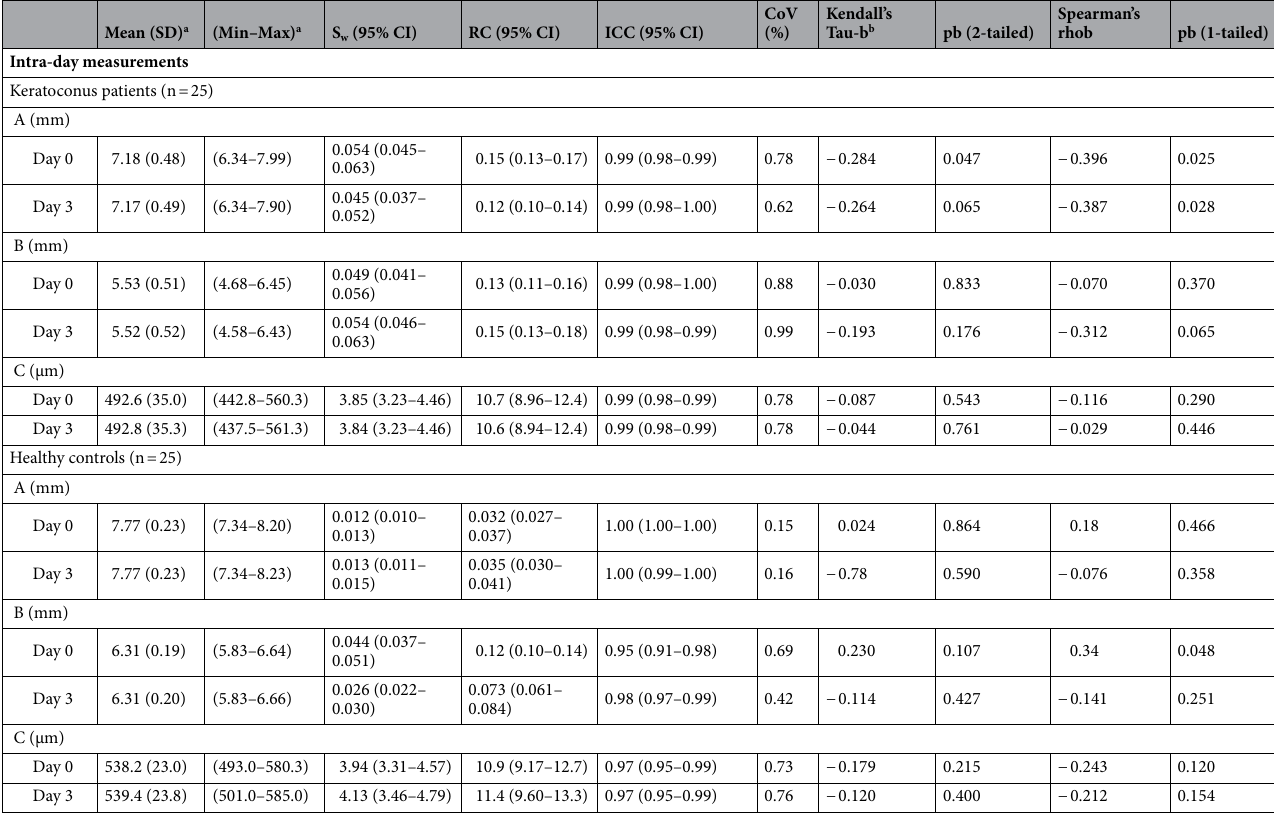
Table 2. Descriptive statistics and repeatability of intra-day Pentacam measurements in subjects with keratoconus and healthy controls. A = Anterior curvature of the 3 mm zone over the thinnest point (mm). B = Posterior curvature of the 3 mm zone under the thinnest point (mm). C = Thickness of the thinnest point on the cornea (μm). a Subject mean. b Subject SD versus subject